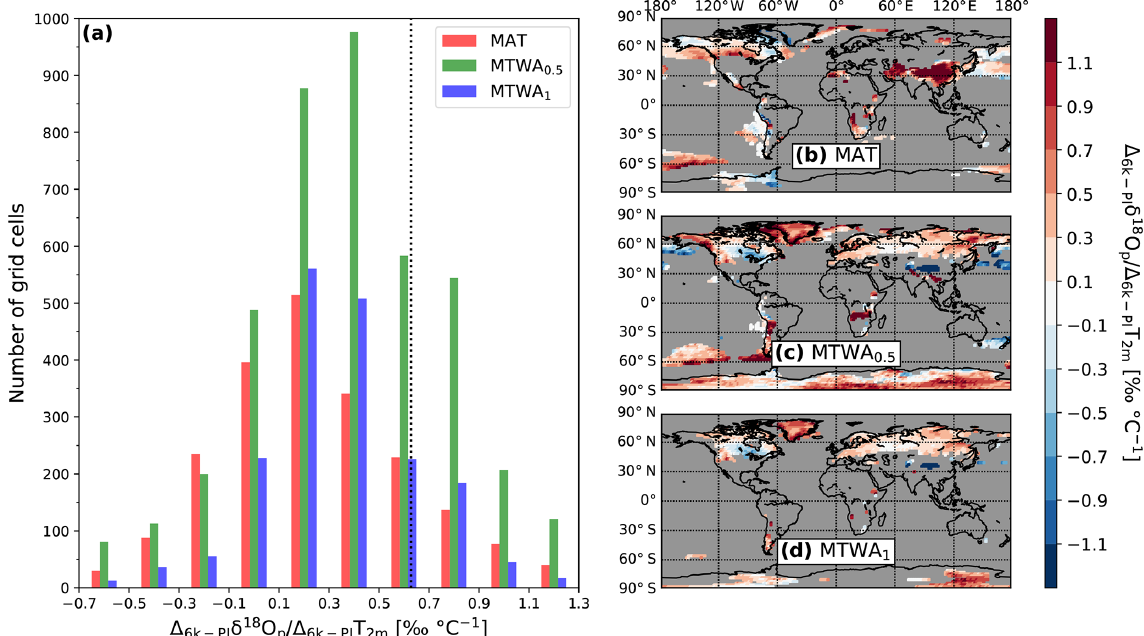
Figure 10. (a) Histogram of the calculated temporal 6k–PI δ 18 O p – T gradients for all grid cells in which (i) simulated mean temperature for both PI and 6k is lower than 20 ◦ C and (ii) absolute change in temperature between the 6k and PI control simulations is at least 0.5 ◦ C (MAT, WTMA 0 . 5 ) or 1 ◦ C (WTMA 1 ). The dotted line shows the simulated mean spatial PI δ 18 O p – T gradient of 0.63‰ ◦ C − 1 . The gradients are calculated in three different ways: with the annual mean δ 18 O p and temperature values where the mean δ 18 O p and temperature values of the warmest month where δ 18 O p and temperature values of the warmest month where in (b) , (c) and (d) ,